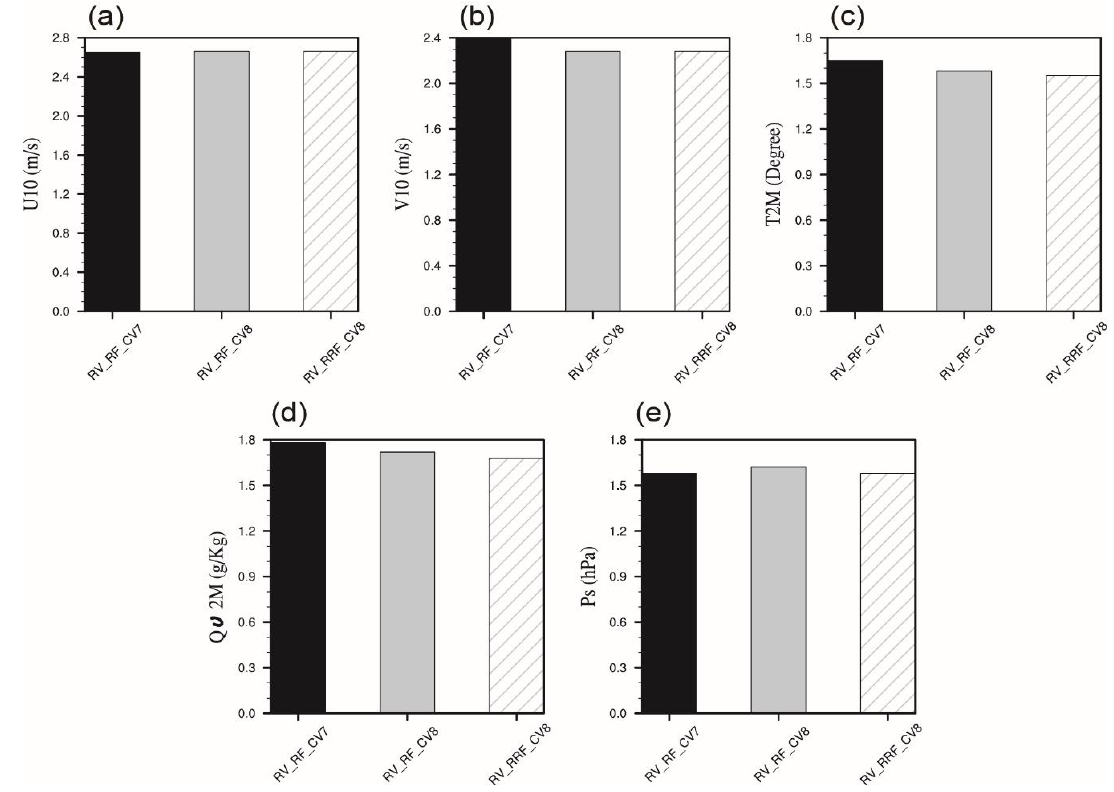
Figure 8. Analyses RMSE versus conventional observations for ( a ) 10 m u-wind, ( b ) 10 m v-wind, ( c ) 2 m temperature, ( d ) 2 m q vapor, and ( e ) surface pressure for RV_RF_CV7, RV_RF_CV8, and RV_RRF_CV8, respectively, at 0000 UTC 22 July 2010.